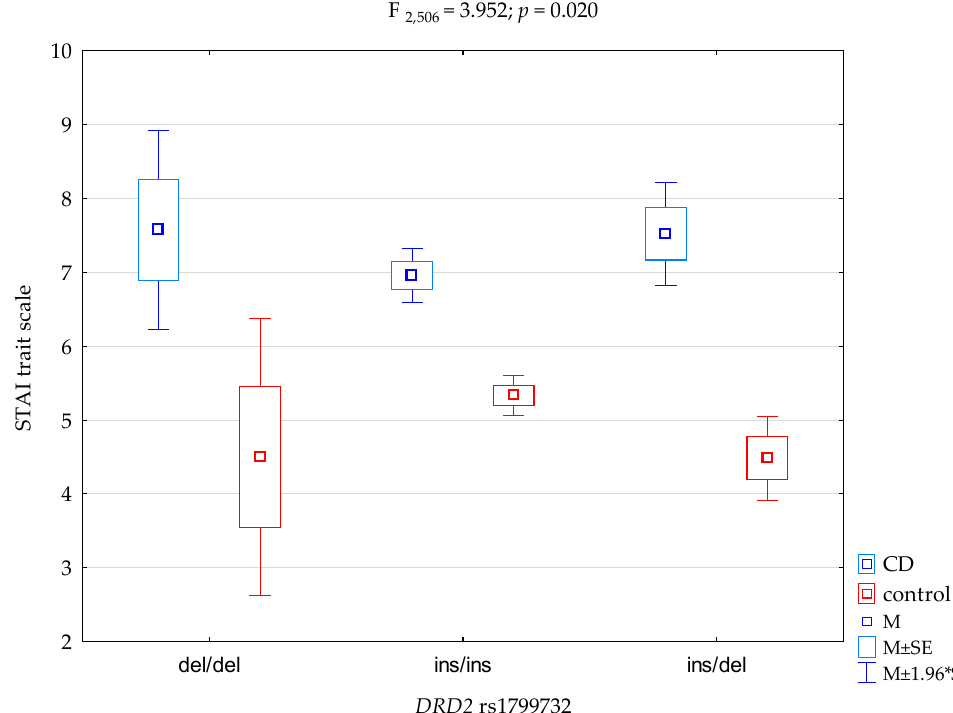
Figure 1. Interaction between the patients diagnosed with polysubstance use disorder comorbid with cannabinoid dependence (CD)/control and the DRD2 gene rs1799732 and STAI trait scale. Table 5. Post-hoc test (Bonferroni) analysis of interactions between the patients diagnosed with polysubstance use disorder comorbid with cannabinoid dependence/control and the DRD2 gene rs1799732 and STAI trait scale.